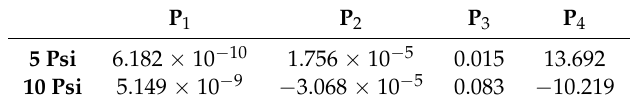
Figure 7. Third order polynomial fitting for volume versus duration data. Volume is kept as the independent variable. Table 1. The polynomial coefficients for Equation (3) at 5 and 10 psi air pressure